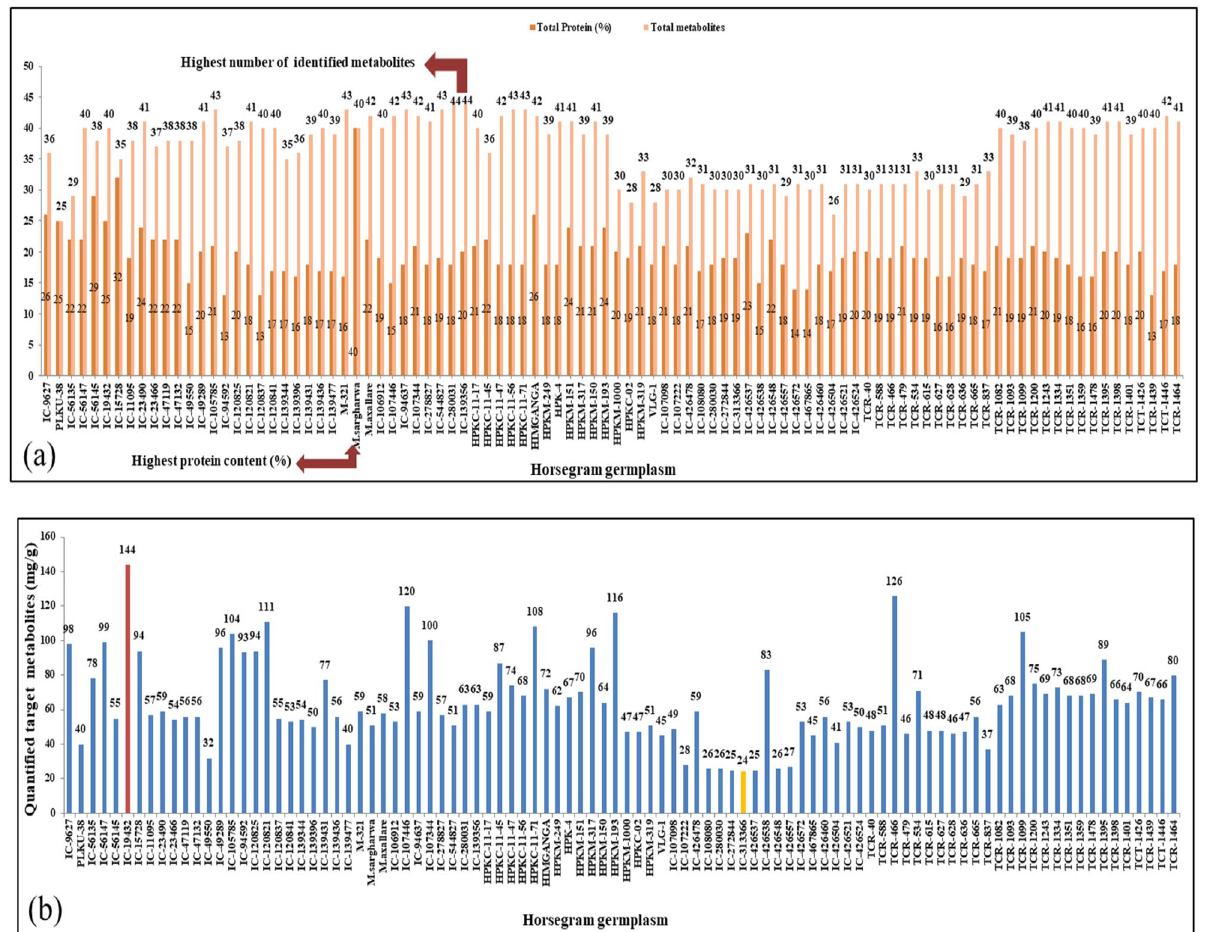
Figure 3. (a) Distribution of total protein and targeted metabolites among the horsegram germplasm [in terms of total number of metabolites identified and total % protein] (b) Quantification of identified metabolites in whole horsegram